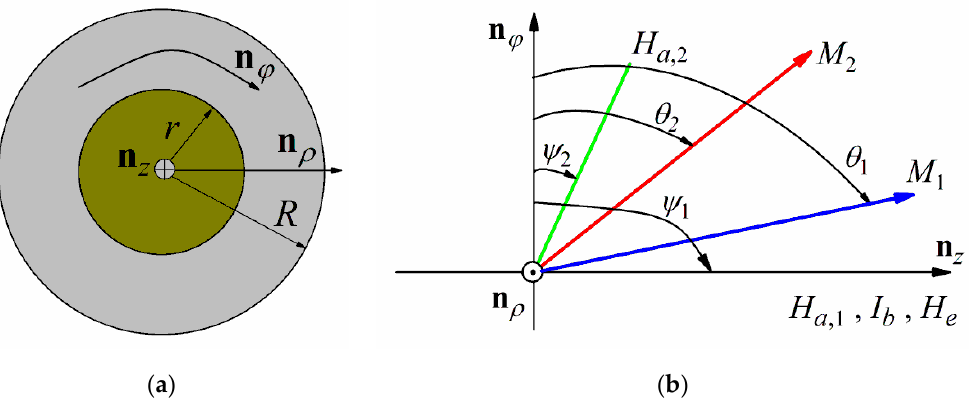
Figure 1. ( a ) The microwire cross-section and unit vectors n ρ , n ϕ and n z of the coordinate system used for analysis. ( b ) A sketch of the angles in the model lying within the n ϕ – n z